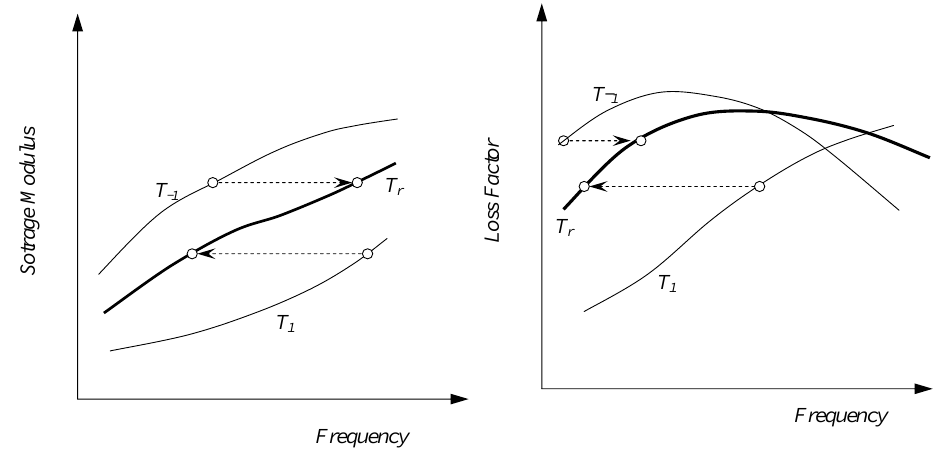
Fig. 1. Illustration of the Frequency-Temperature Superposition Principle